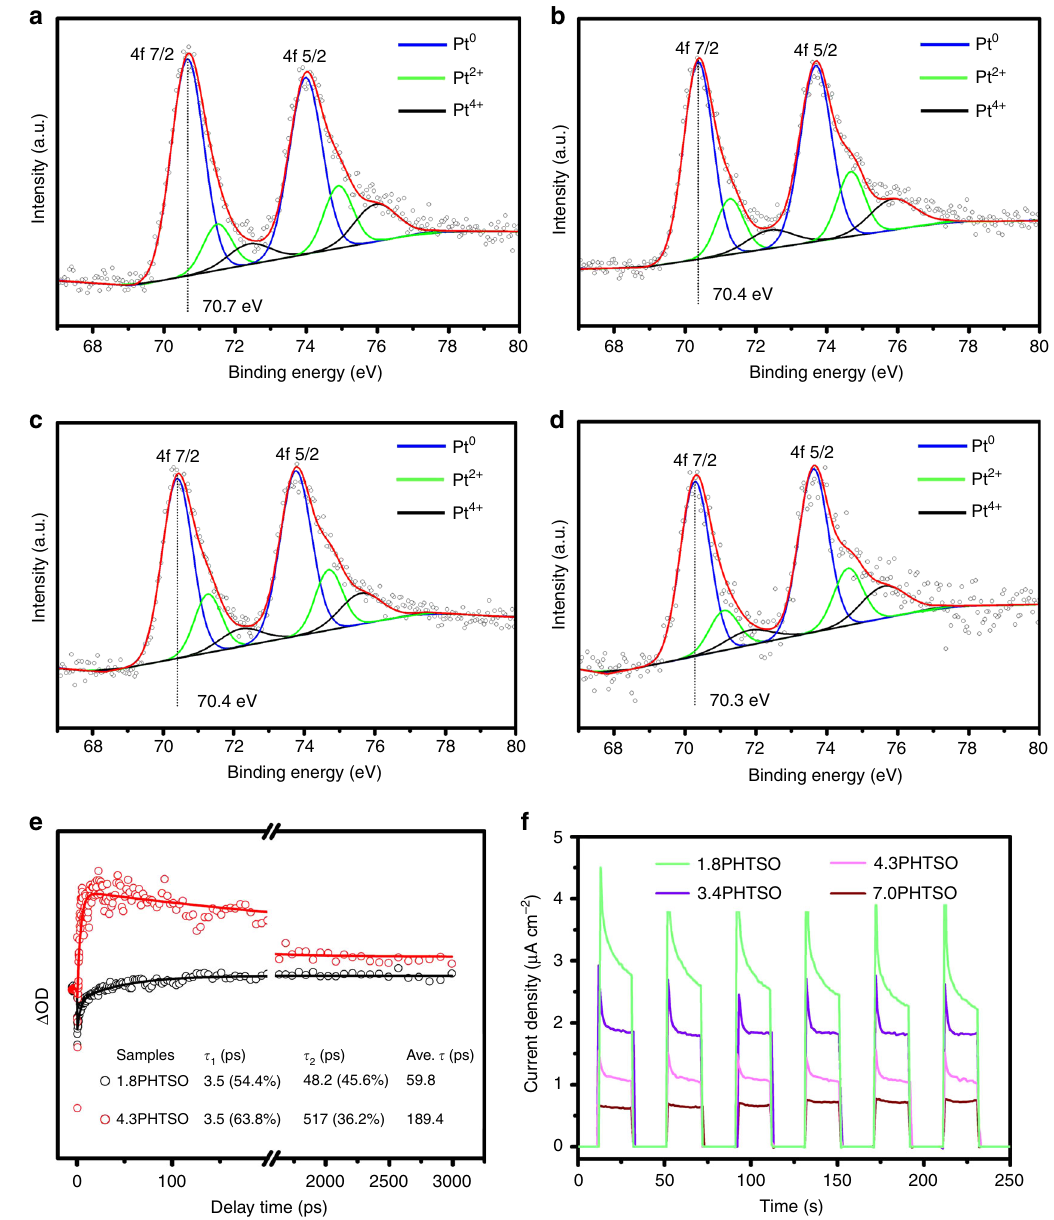
Fig. 3 Electronic properties of x PHTSO. High-resolution Pt 4f XPS spectra of a 1.8PHTSO, b 3.4PHTSO, c 4.3PHTSO, and d 7.0PHTSO. e The kinetics of the characteristic transient absorption band observed at 350 nm in the fs-TA spectra after 310 nm excitation of samples 1.8PHTSO and 4.3PHTSO. The solid lines were the curves fi tted by a two exponential. f Transient photocurrent response of x PHTSO ( x = 1.8, 3.4, 4.3, and 7.0), where a 300 W Xe lamp is used as the light source and a 0.5 M Na 2 SO 4 solution is used as the